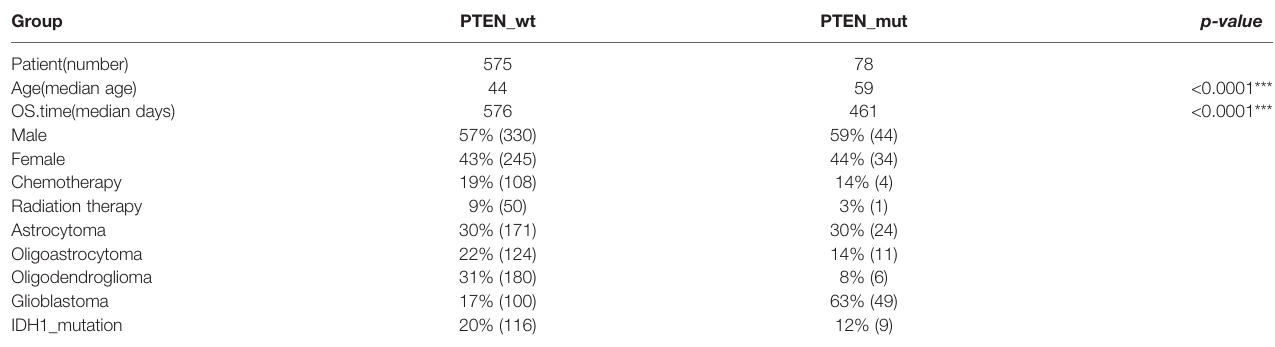
TABLE 1 | Clinical information of the PTEN-wt and PTEN-mut subgroups (*** signi fi cant difference).